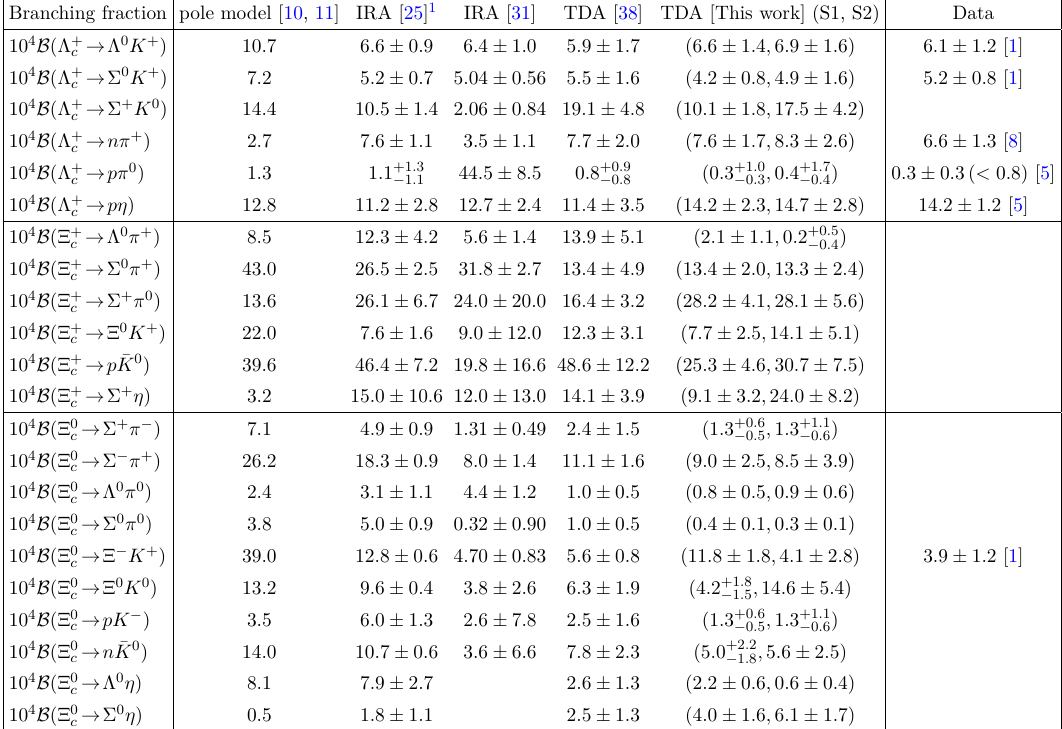
Table 6 . Singly Cabibbo-suppressed (SCS) branching